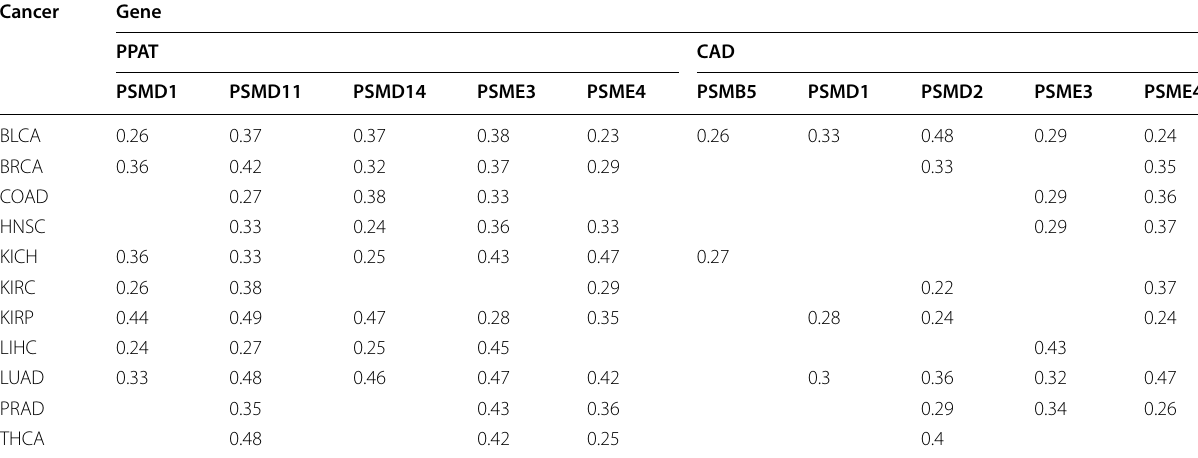
PPAT, phosphoribosyl pyrophosphate amidotransferase; CAD, carbamoyl-Phosphate synthetase 2, aspartate transcarbamylase, and dihydroorotase; PSMD1, proteasome 26S subunit, non-ATPase 1; PSMD11, proteasome 26S subunit, non-ATPase 11; PSMD14, proteasome 26S subunit, non-ATPase 14; PSME3, proteasome activator subunit 3; PSME4, proteasome activator subunit 4; PSMB5, proteasome subunit beta 5; PSMD2, proteasome 26S subunit, non-ATPase 2